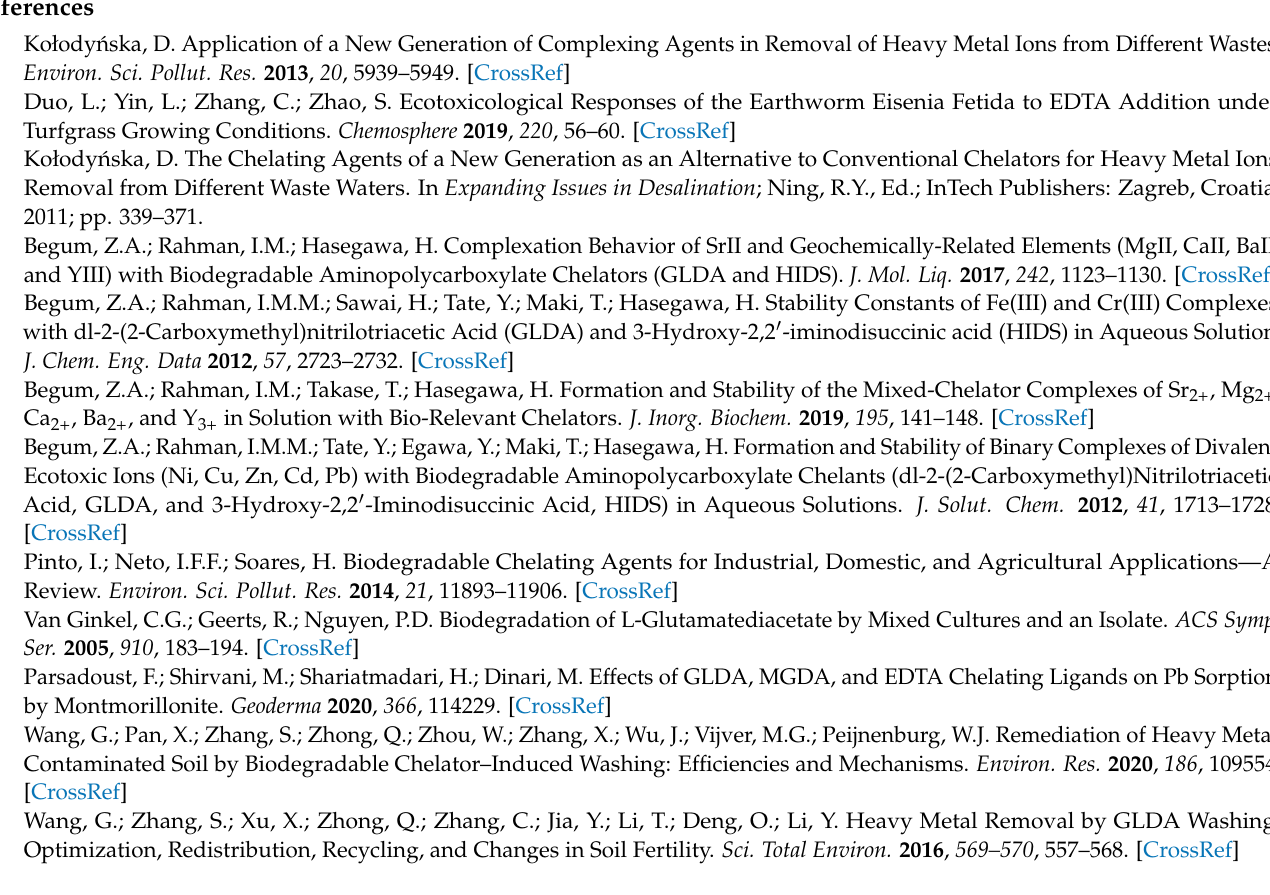
Supplementary Materials: The following are available online. Table S1. Experimental values of the protonation constants of L-glutamic-N,N-diacetic acid (L-GLDA) in different ionic media, at different temperatures and at different ionic strengths. Table S2. Overall metal ligand complex